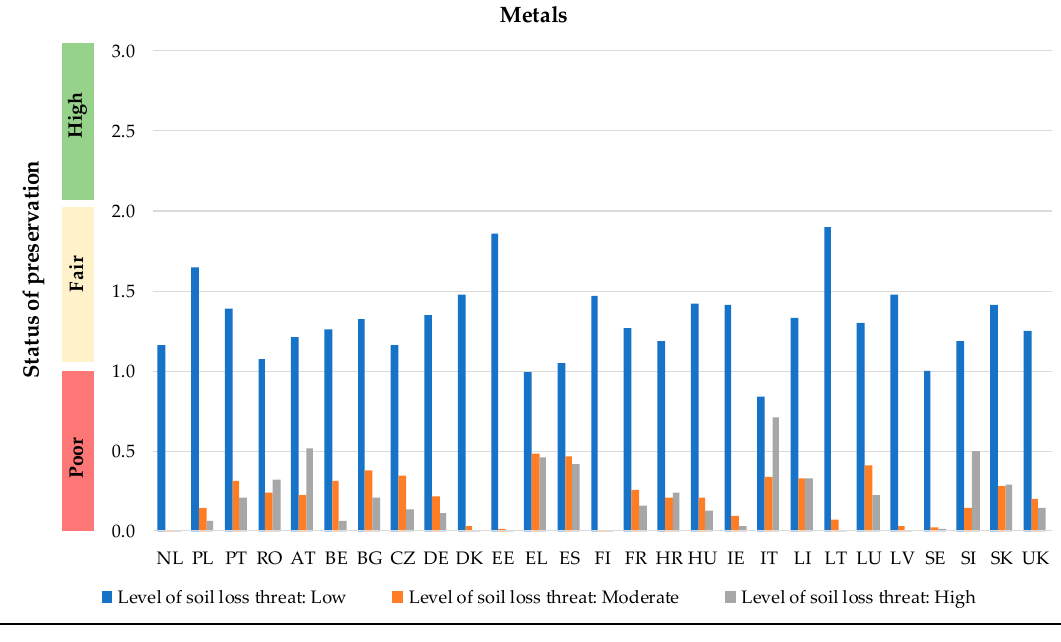
Figure 7. Mean values per country level for metals per level of soil-loss threats: Values close to 1 indicate poor status of preservation, values close to 2 indicate fair conditions of preservation, and values close to 3 good preservation status.